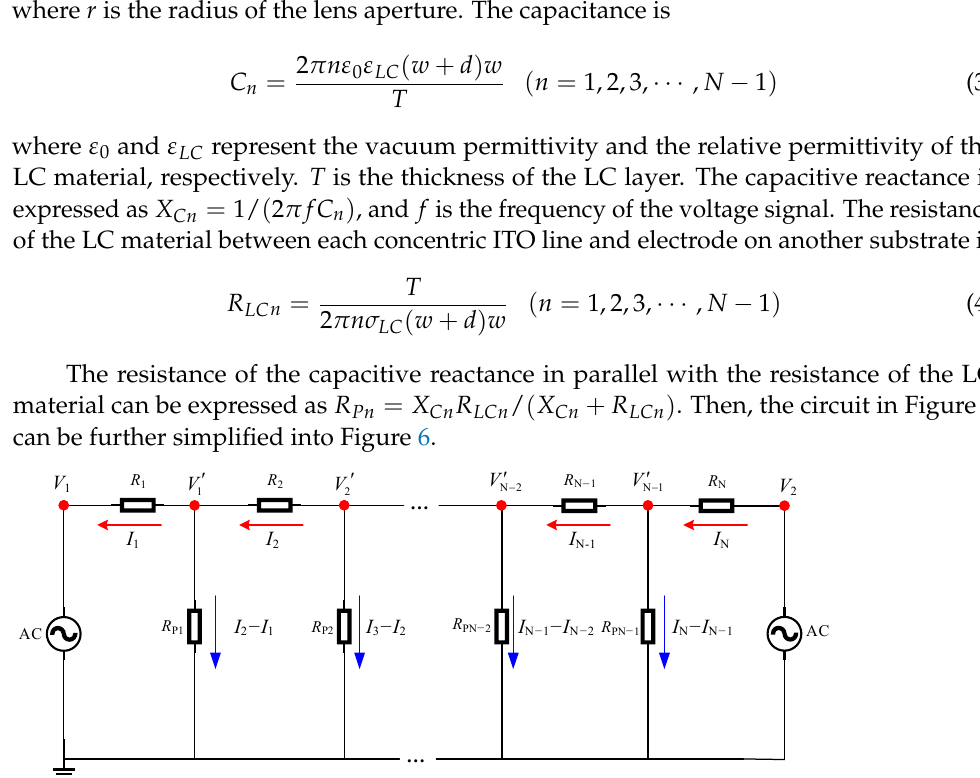
Figure 6. The further simplified circuit from Figure 5.